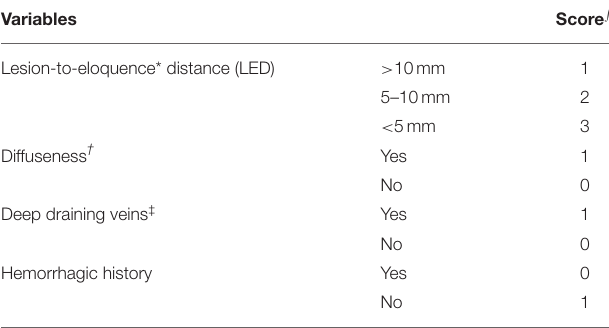
TABLE 4 | HDVL grading